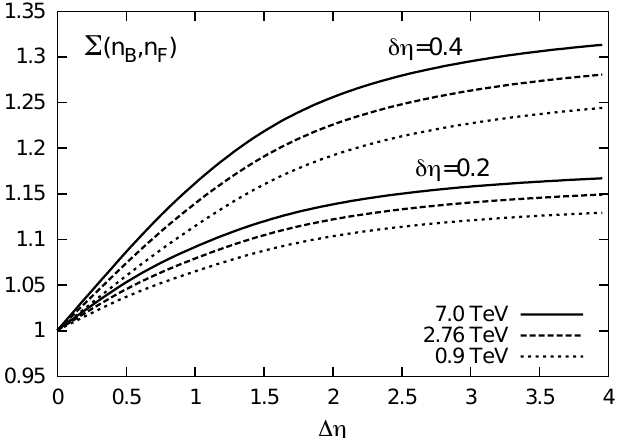
) , between multiplicities in two small , n F B